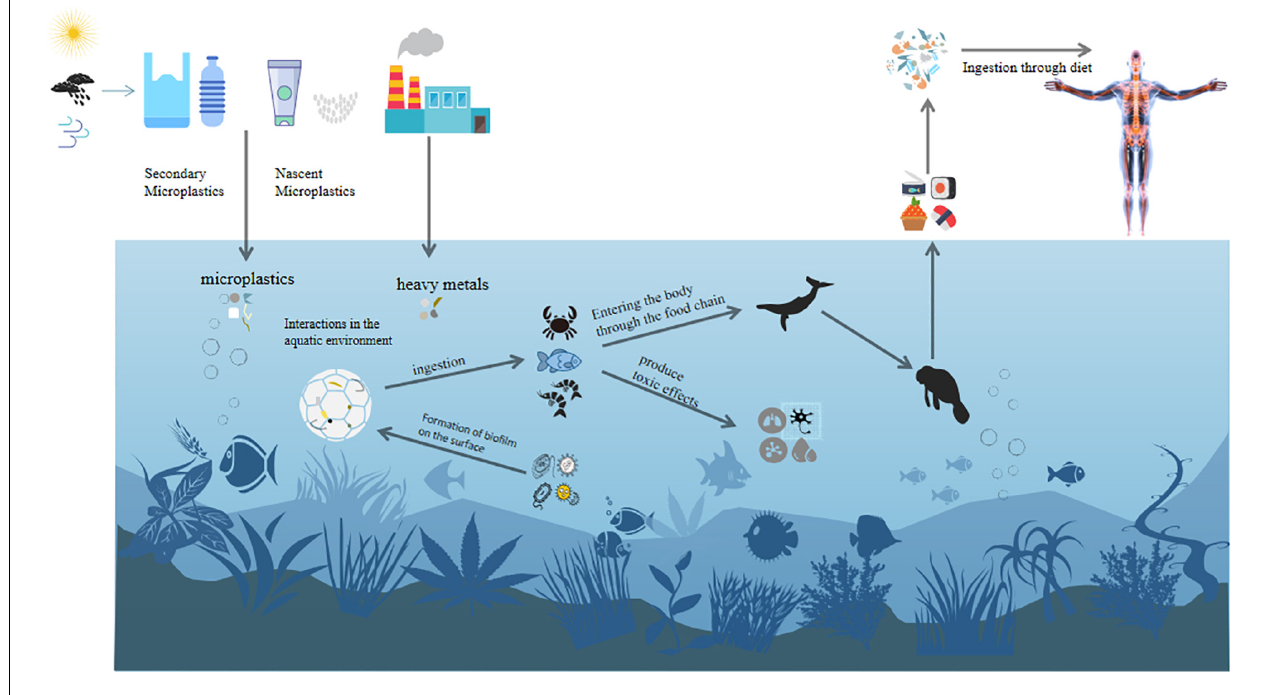
FIGURE 5 | Ecological risks of MPs and heavy